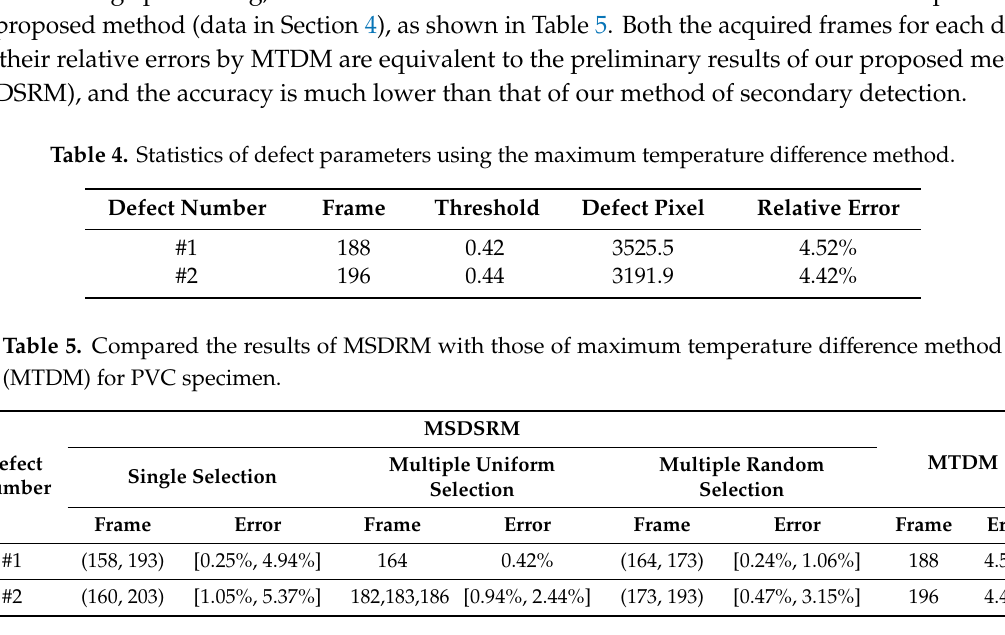
Figure 26. The curves of average temperature difference between the defect area and sound area over time.